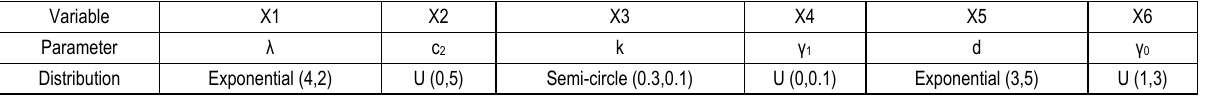
Table 1. Distributions of